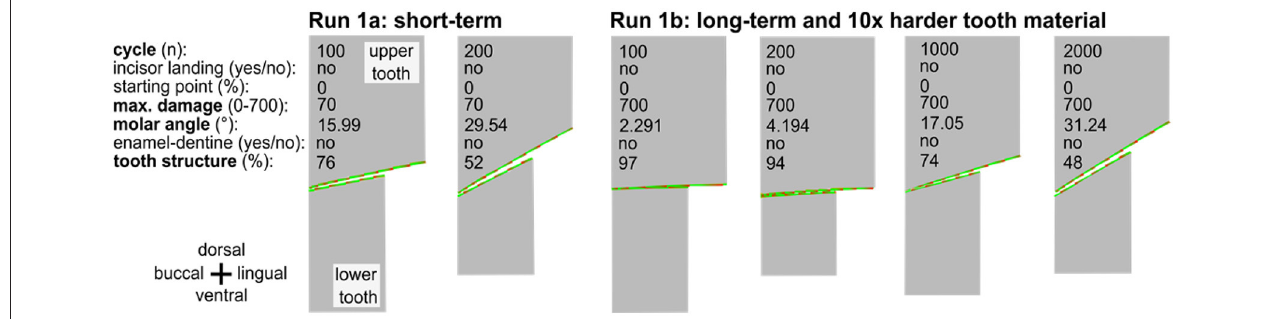
FIGURE 4 | The long-term simulation run of an occluding upper and lower cheek teeth indicating 2,000 cycles with 10 × harder tooth material as compared to run 1a. The long-term run leads to very similar results after 1,000 or 2,000 cycles within the range of variation to be expected due to the random component in the tooth